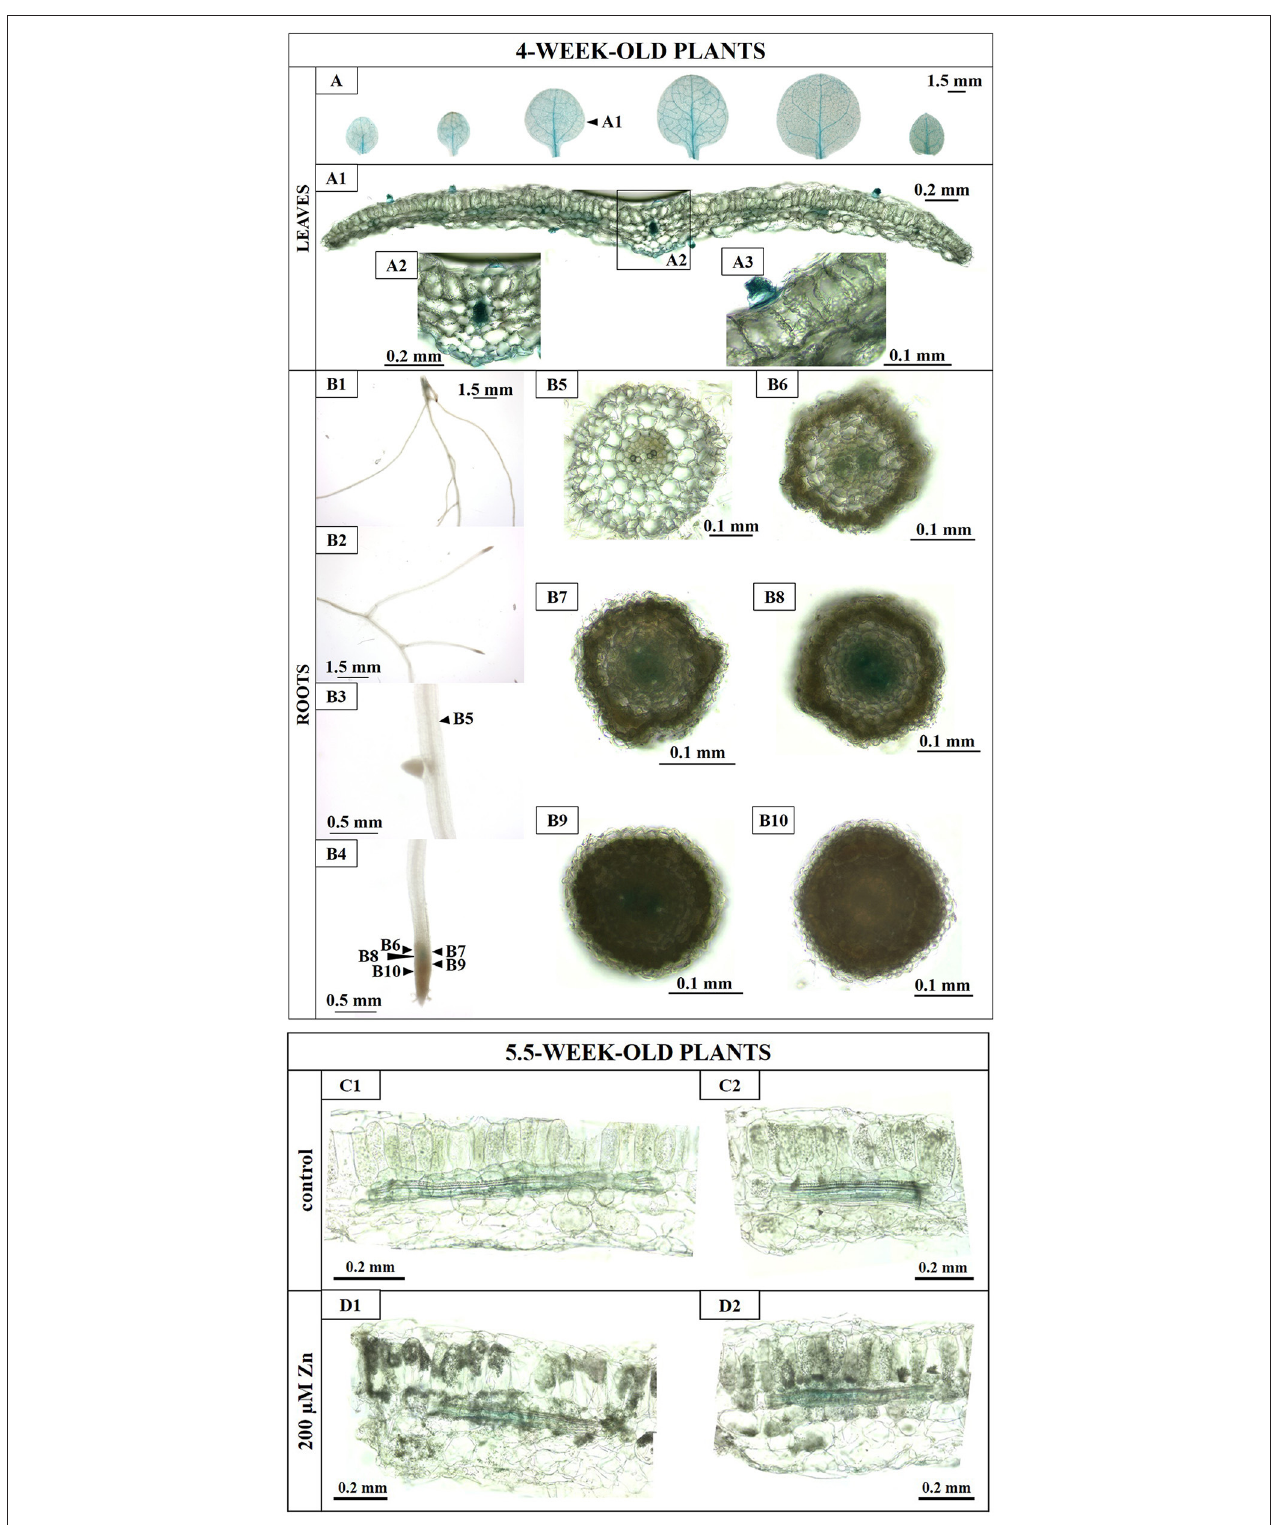
FIGURE 8 | Histochemical GUS assay in transgenic promNtNRAMP3::GUS tobacco. (A–B4) : 4-week-old plants: Transgenic promNtNRAMP3::GUS tobacco plants were grown for 4 weeks at the control medium ( ¼ Knop’s). (A) depicts leaves. (A1) Cross-section through the blade of the 3rd leaf (counting from the base). (A2) Magnifications of the main vein and surrounding tissues. (A3) Fragment of a cross-section of a leaf blade with a trichome. (B) Depicts roots. (B1) Basal part of the root;